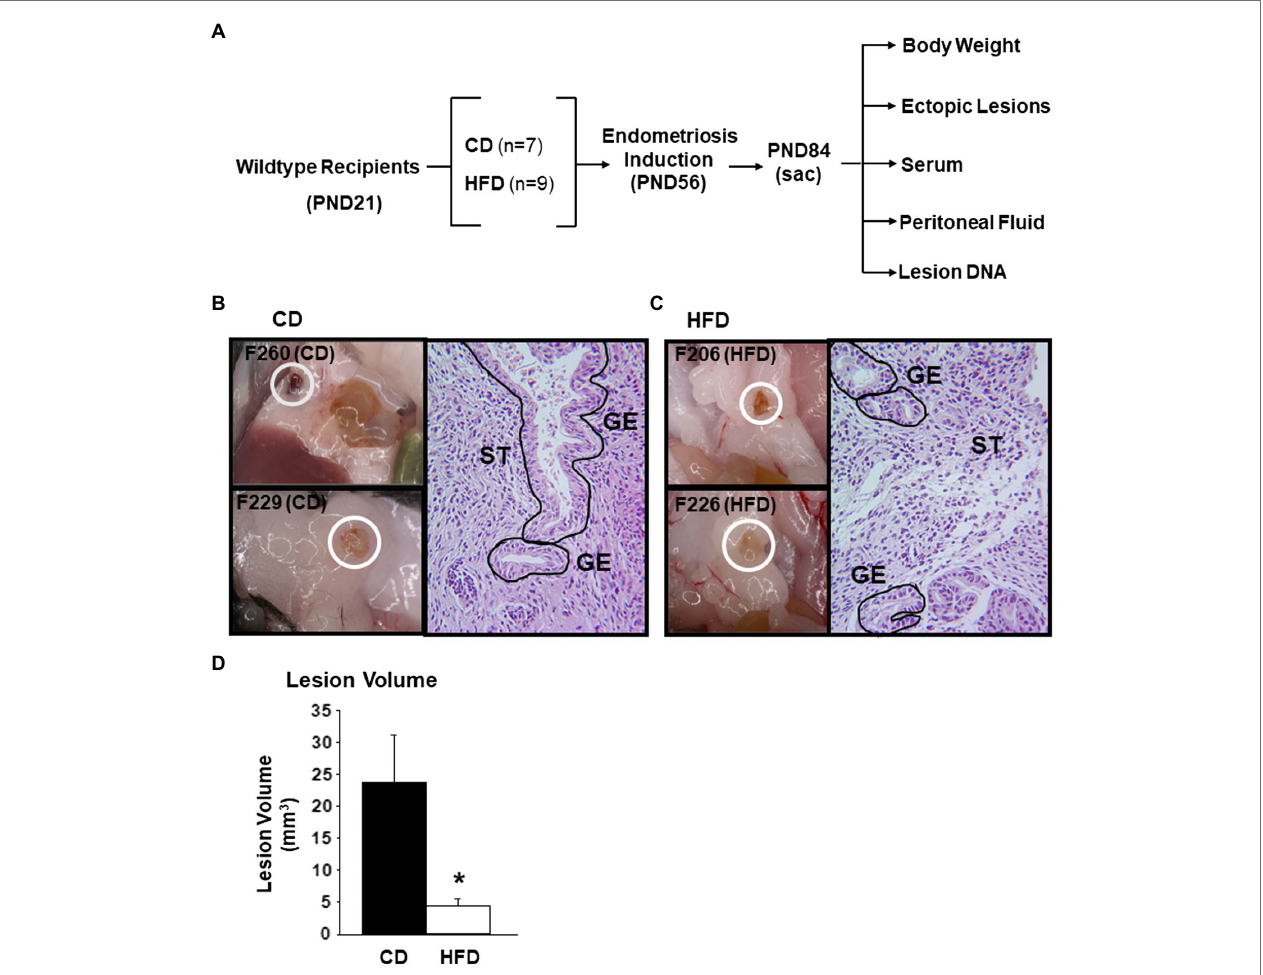
FIGURE 1 | Experimental design for characterization of endometrial-like lesions derived from immunocompetent mice fed CD or HFD. (A) Schematic representation of generation of lesions and their analyses. Female WT mice were used as recipients of endometrial fragments from WT donors, with the indicated numbers of mice used. (B) Representative bright-field images of lesions from two mice (F260 and F229) fed control diet (CD) and an H&E-stained section of one lesion (F260), showing glandular epithelial (GE) and stromal (ST) cells. (C) Representative bright-field images of lesions from two mice (F206 and F226) fed high-fat diet (HFD) and an H&E-stained section of one lesion (F206), showing glandular epithelial (GE) and stromal (ST) cells. (D) Mean lesion volumes from CD-fed ( n = 7) and HFD-fed ( n = 6) recipients. * p < 0.05 by Student’s t